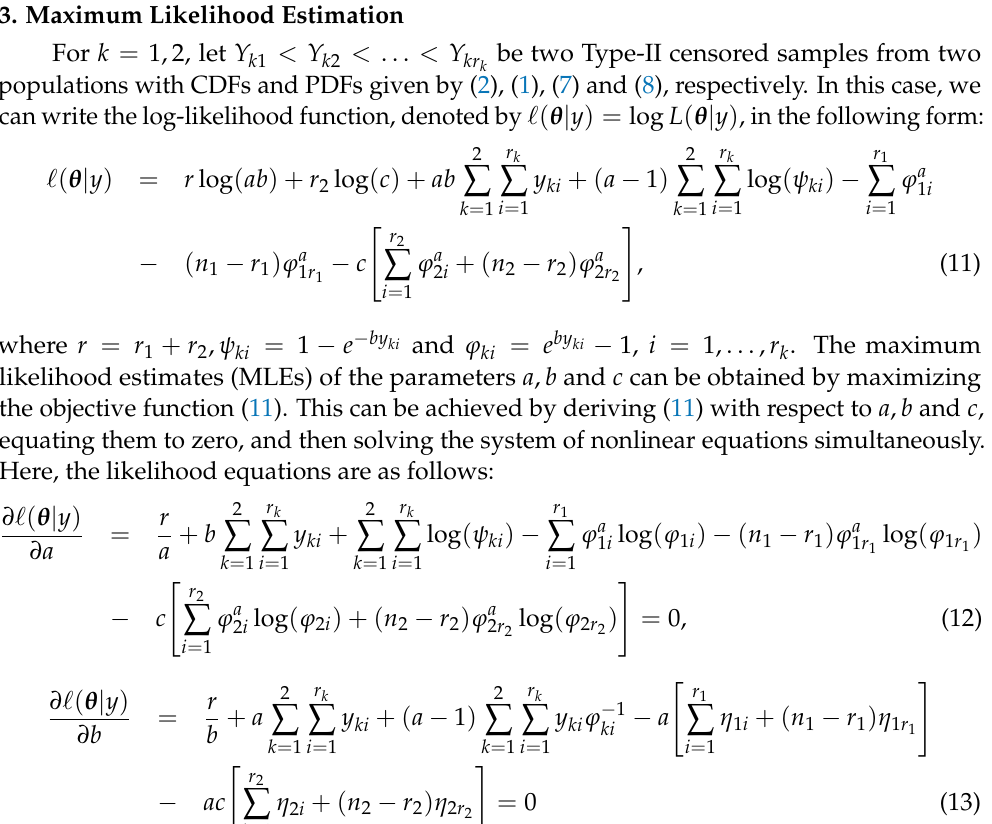
Figure 1. Plots of PDF, CDF, RF and HRF of the MKE